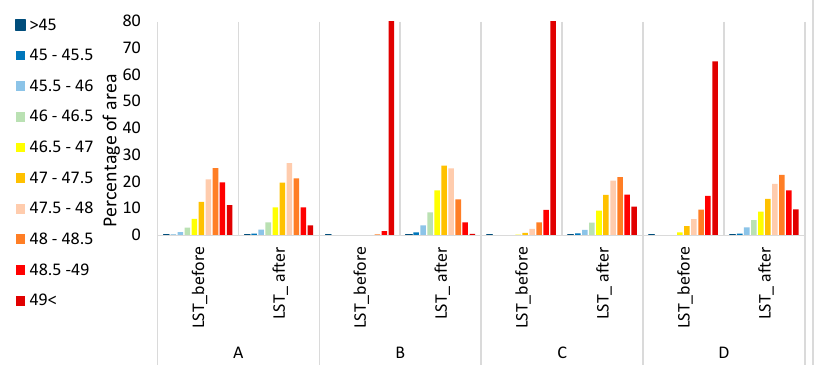
Figure 7. Percentage area of different pistachio tree temperature (LST, °C) classes before and after foliar application of gypsum (plot ( A )) and of gypsum again, gypsum, NAX-95 (calcium-based suspension coating), and sulfur in plots ( A – D ), respectively. Figure 8 presents the land cover maps and daily evapotranspiration by pistachio trees at 1 mm intervals in each of the plots. In plot A, where the trees were foliar-sprayed twice with gypsum, daily evapotranspiration was similar on both dates, as found for tempera- ture. For example, trees with evapotranspiration of 0.4–0.5 mm/day occupied the highest percentage of tree area on the first spraying date (36%), and the second date (38%). In plot B, in which the trees were sprayed once with gypsum, the largest percentage area was occupied by trees with evapotranspiration of 0.3–0.4 mm/day (35%) and 0.4–0.5 mm/day (28%). Trees in the two highest daily evapotranspiration categories (0.4–0.5 and 0.5–0.6 mm/day) occupied 31% and 30% of total tree area, respectively.